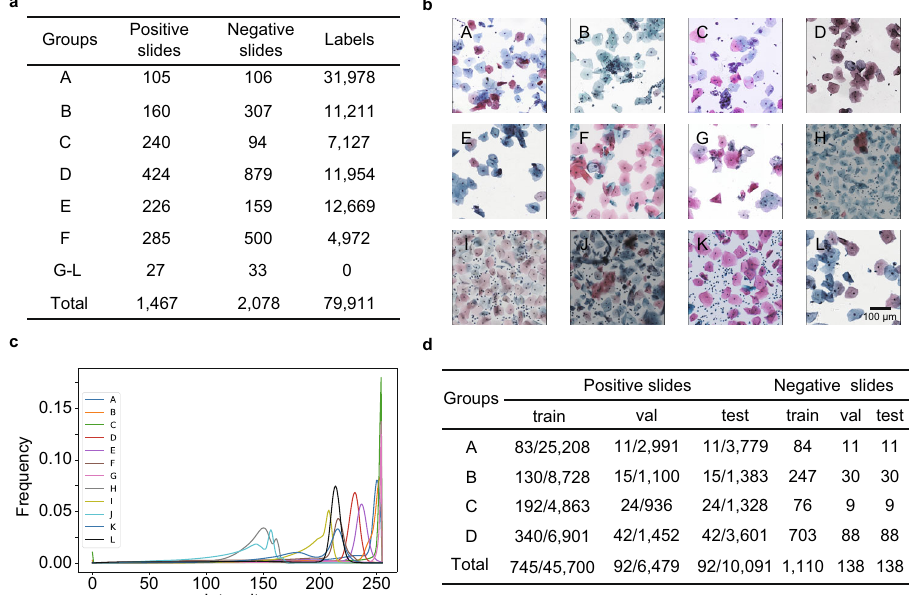
Fig. 2 Overview of multi-center WSI datasets. a The collected 12 groups of WSI datasets from fi ve hospitals and fi ve kinds of scanners. There are in total 3,545 WSIs with 79,911 annotated lesion cells by a consensus of three cytopathologists. b Cervical image instances of the 12 groups, showing diverse image styles of staining and imaging characteristics. c The numerical distributions of the 12 groups in the value channel of HSV space (hue, saturation, value), further con fi rming the difference of image styles. d The division of training set, validation set, and test set with a slide-wise ratio of 8:1:1 on groups A – D, which are used for training our